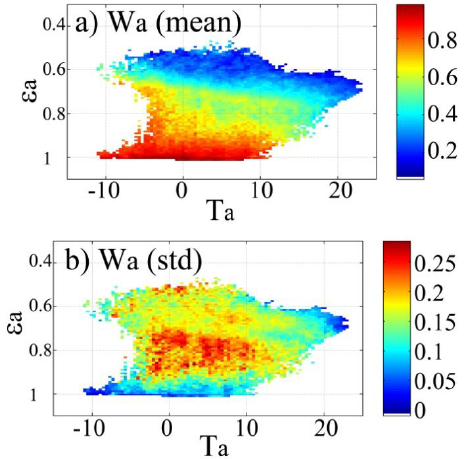
Fig. 5. (a) Mean value and (b) standard deviation for atmospheric emissivity Fig. 4. (a) Mean value and (b) standard deviation for relative hu-